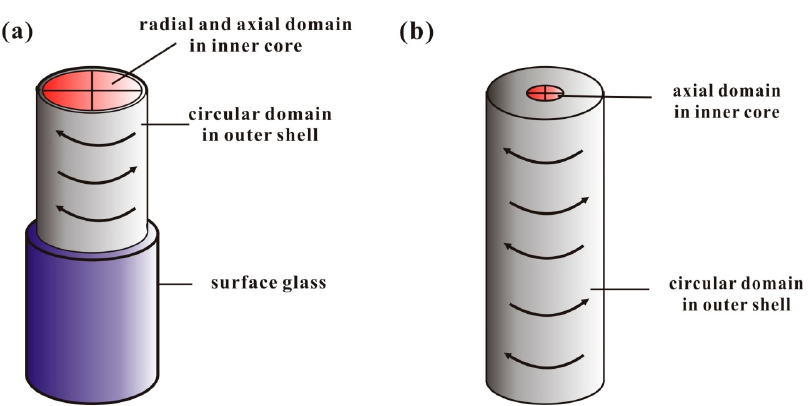
Figure 14. Magnetic domain distribution of ( a ) as ‐ cast and ( b ) glass ‐ removed Fe 73.5 Cu 1 Nb 3 Si 13.5 B 9 fibers.